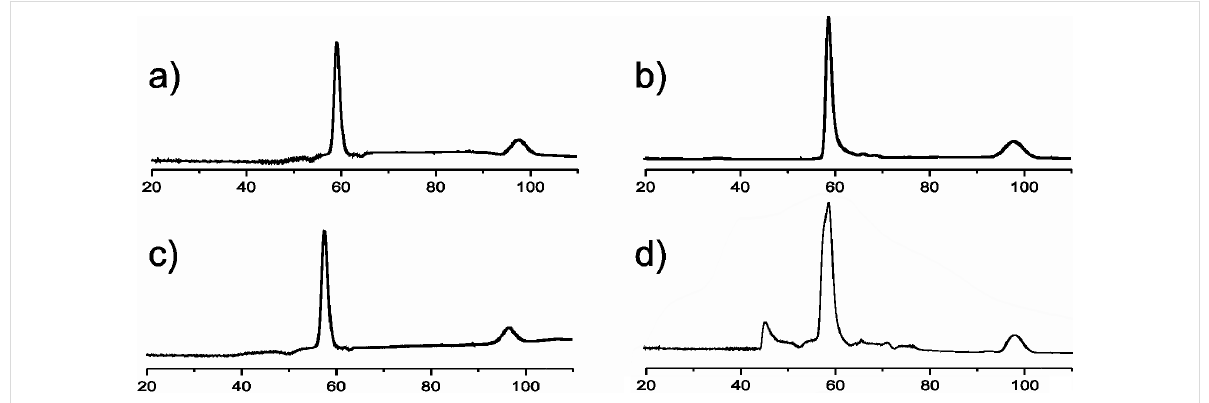
Figure 6: Size-exclusion chromatograms of equimolar mixtures of B3 β 2 γ with (a) Acid-pp, (b) V a V d E e E g , (c) L a L d D e D g , and (d) I a F d E e E g (50 µM of peptide concentration in phosphate buffer 100 mM). The chromatogram of the tetrameric B3 β 2 γ /Acid-pp helix bundle serves as the reference.